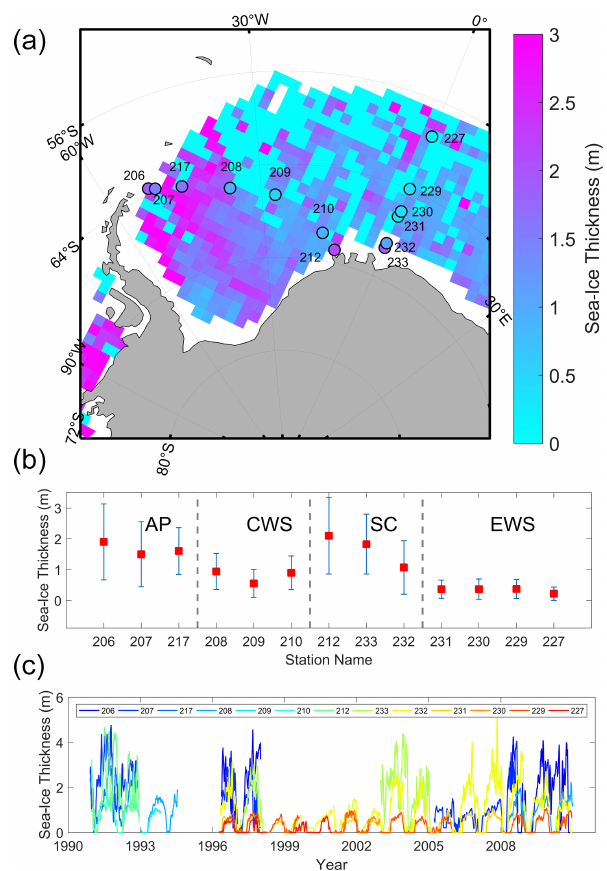
Figure 1. (a) The ICESat-1 sea-ice thickness in the autumn of 2005 in the Weddell Sea and the locations of the moored upward-looking sonars with their mean thicknesses shaded. (b) The mean ULS sea- ice thickness from west to east in the Weddell Sea. The error bars represent the SD of daily ice thickness for individual stations. Dot- ted gray lines divide the 13 stations into four parts: the Antarctic Peninsula (AP), the central Weddell Sea (CWS), the southern coast (SC) and the eastern Weddell Sea (EWS). (c) The time series of daily sea-ice thickness of all 13 stations based on a 15d moving